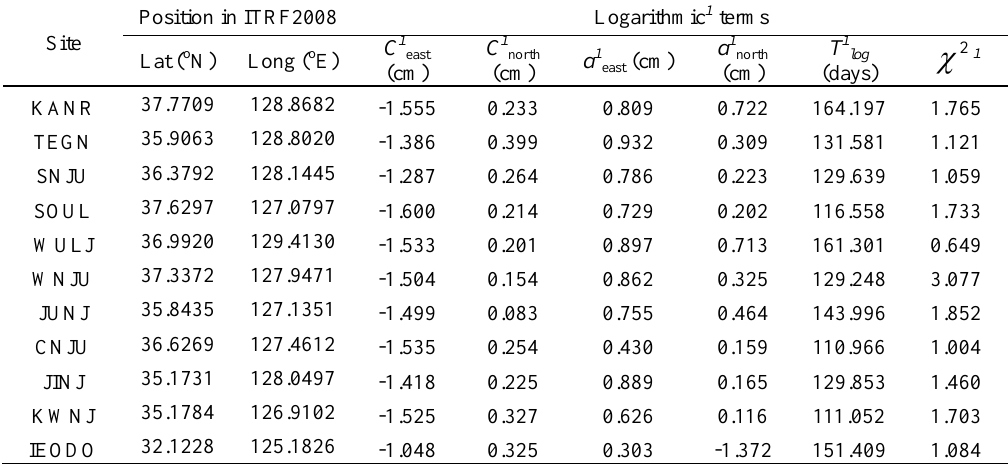
Table 1. Postseismic parameter of logarithmic decay